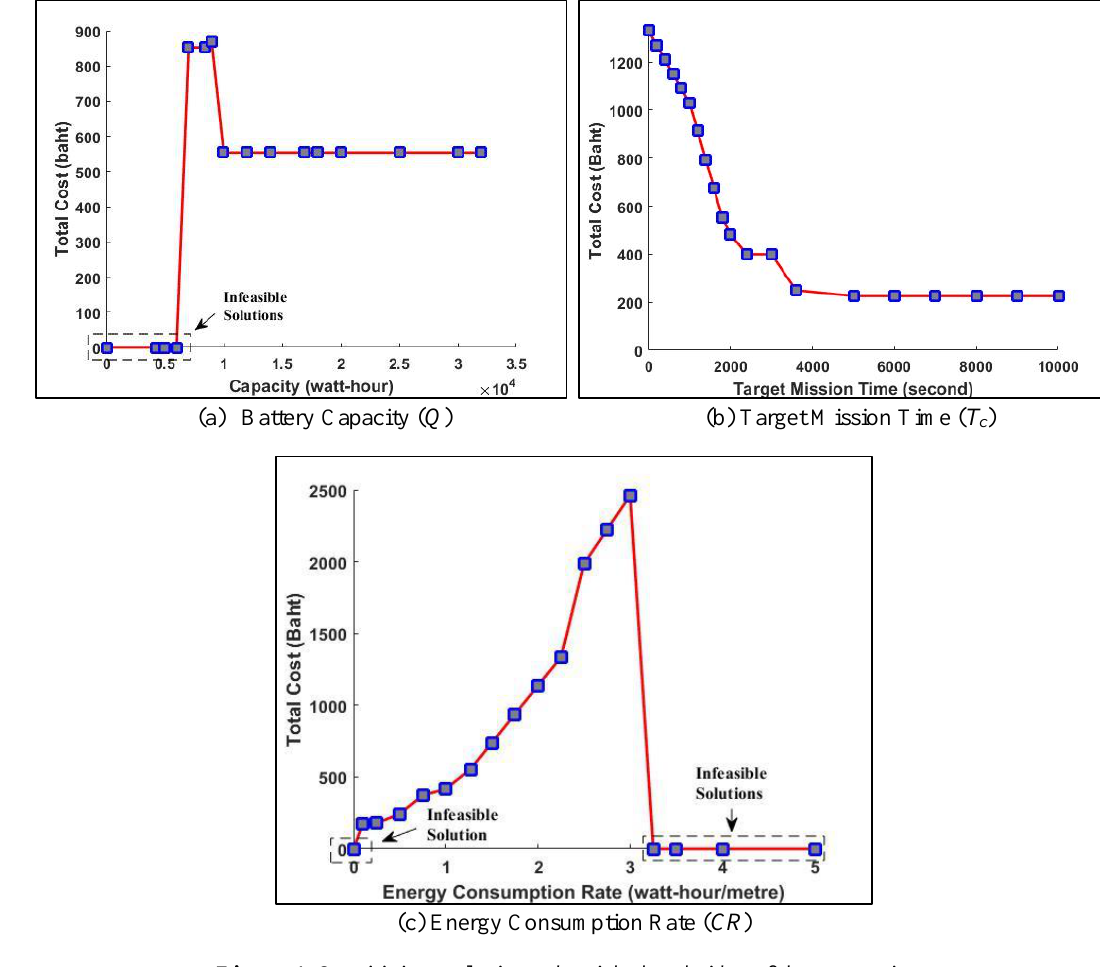
Figure 4. Sensitivity analysis on the right-hand sides of the